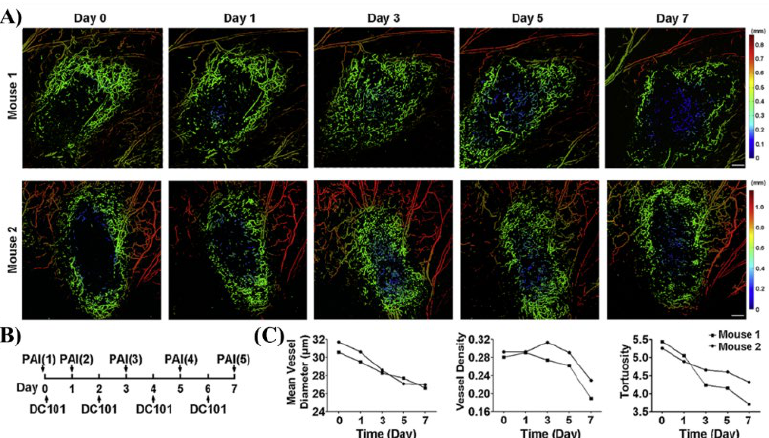
Figure 5. OR-PAM monitored the dynamic changes of tumor vasculature in response to DC101 ther- apy. ( A ) Depth-encoded maximum amplitude projection (MAP) of tumor vascularity, ( B ) schematic of therapy response monitoring, and ( C ) quantification of tumor vasculature. Reprinted from Zhou et al., Photoacoustics, 2019, 15: 100143 [22], with permission of Elsevier. In 2022, Kim et al. attempted a study on the photoplethysmography (PPG) system with the explicitness of photoacoustic microscopy of blood vessels in a 532 nm wavelength pulsed laser (AWAVE 532-1W-10K, Advanced Optowave, Ronkoma, NY, USA) [24]. The PPG sensor and PAM signal results were analyzed from data of approximately 60 s, which is more than the actual PPG analysis level (10 s) [24]. In this type of analysis, there are problems, such as the cost and resolution of motion artifacts; however, it is necessary to pay attention to new applications. Figure 6 shows the results of quantifying the changes in PAM vascular motion and PPG signals for five blood vessels.